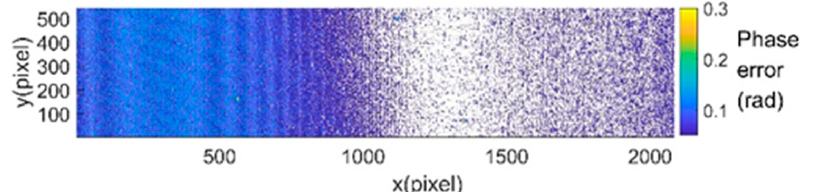
Figure 5. Calculation results of method [8].